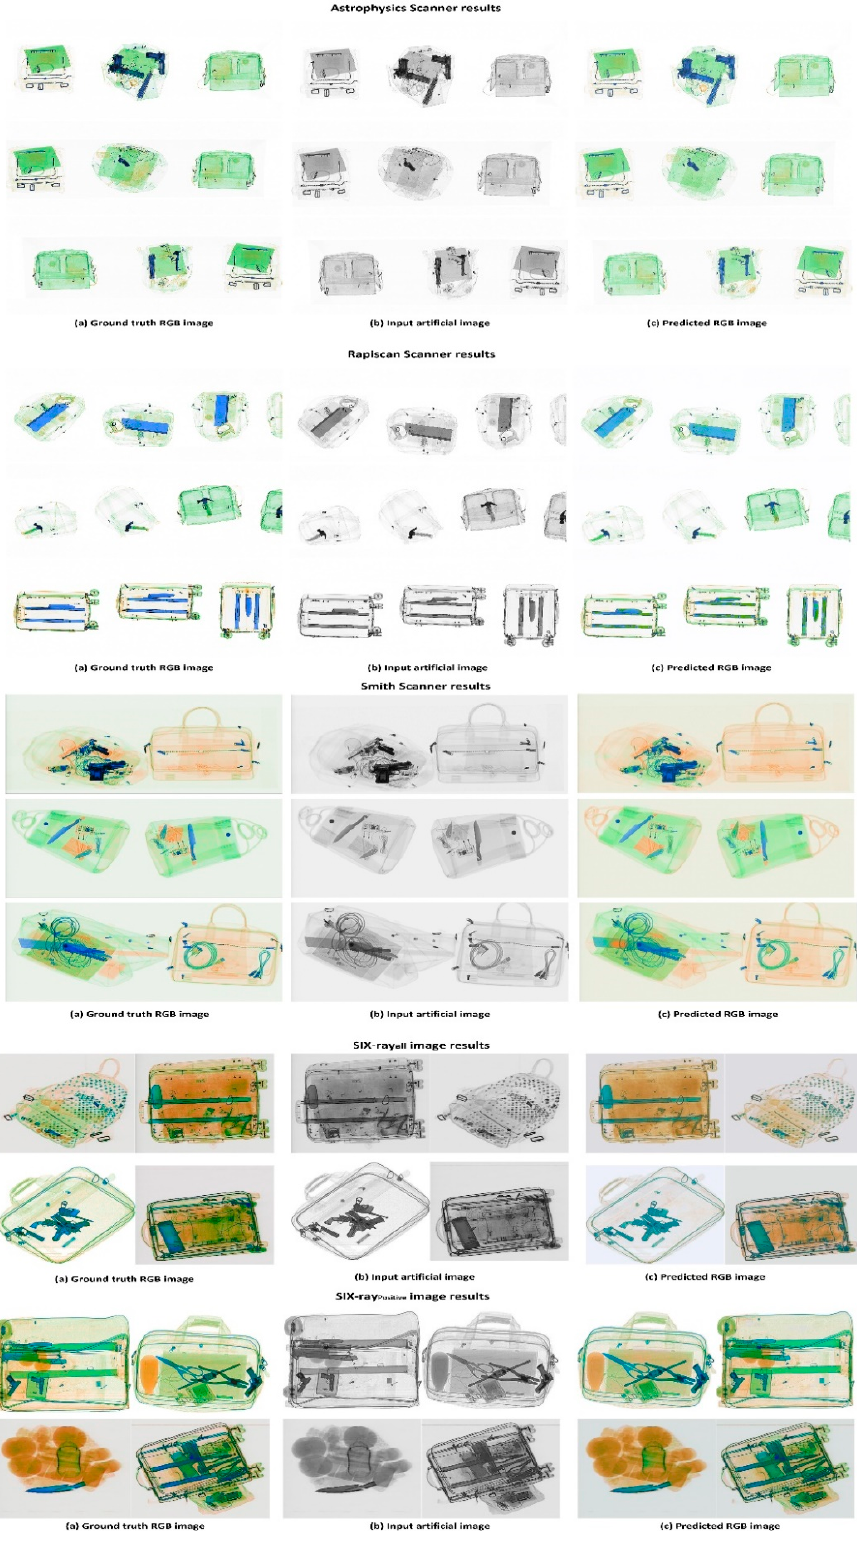
Figure 6. Quality results were obtained from Rapiscan, Astrophysics, Smith, as well as SIXray all and SIXray positive . The result obtained from each scanner is shown in a label above each group of images. Each row consists of ( a ) a Ground truth image, ( b ) an artificial input image, and ( c ) a predicted RGB image.